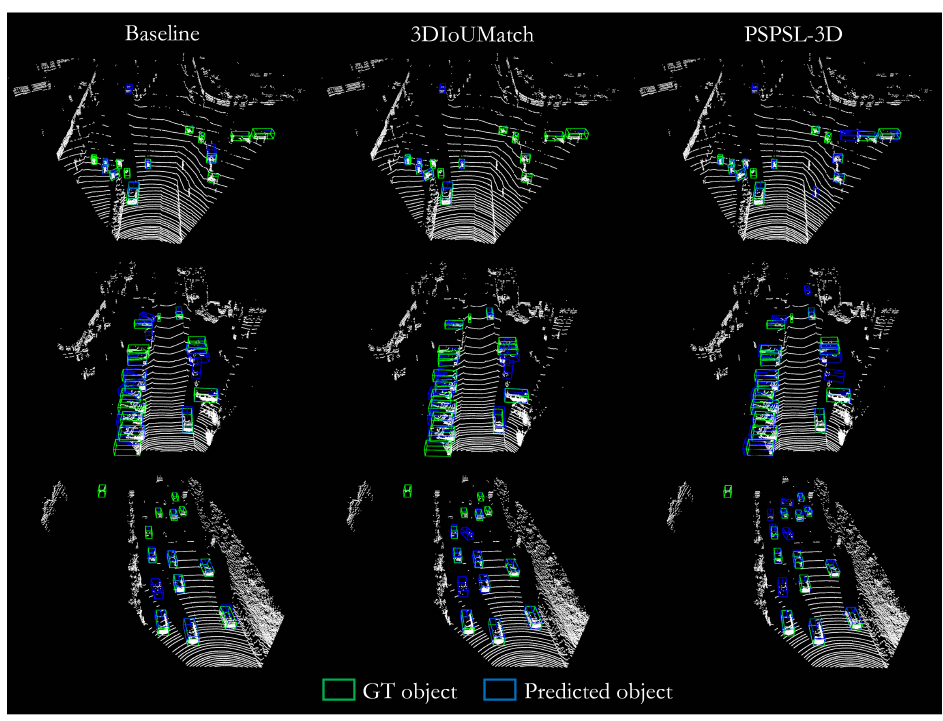
Figure 4. 3D object detection results in the complex scenarios. Baseline, 3DIoUMatch, and PSPSL-3D are trained with R anno = 8%-labeled data. The recall rate of PSPSL-3D is higher than in other methods.